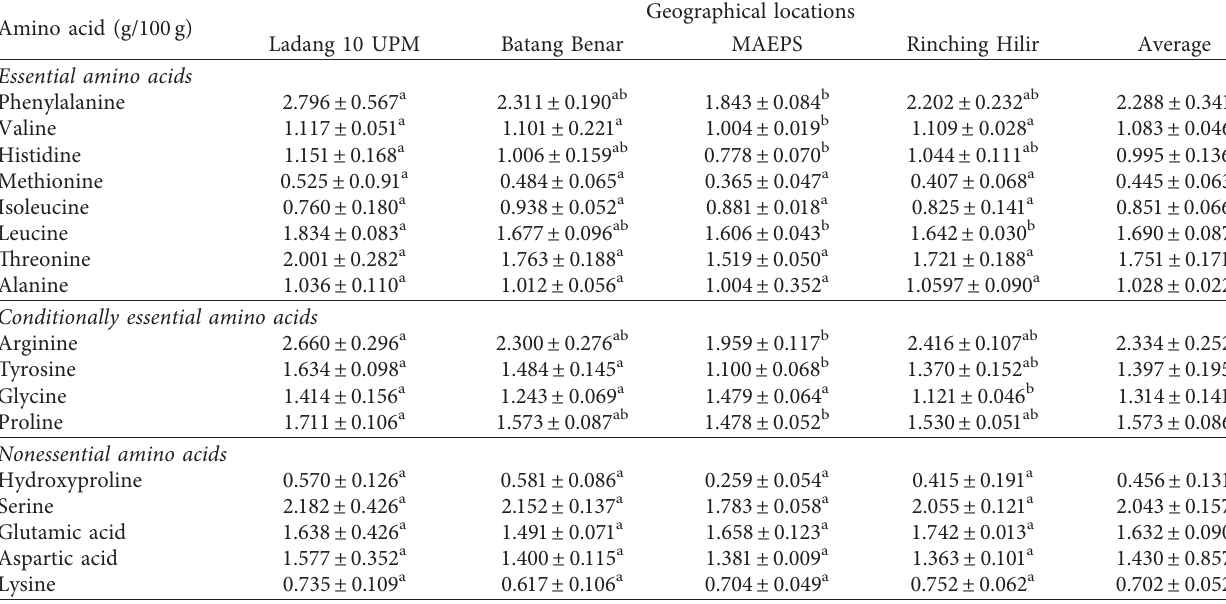
Table 4: Amino acids in bee bread of the stingless bee H. itama. Amino acid